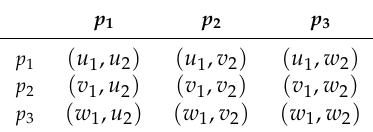
Table 8. NE of G ( θ